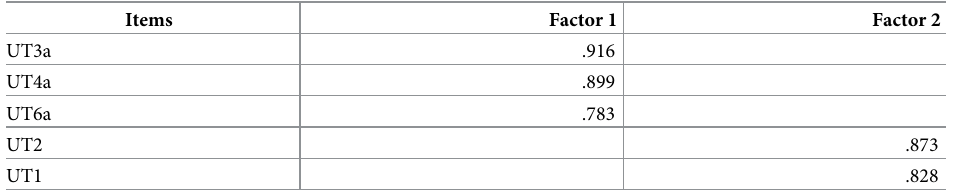
Table 10. Two factors obtained in a variable distrust.